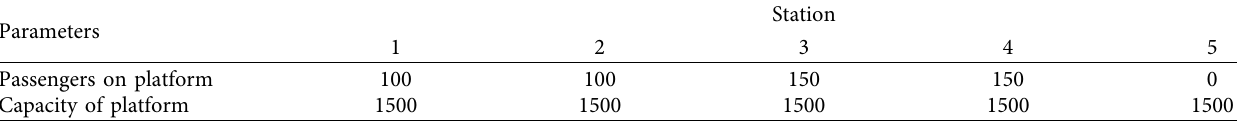
Table 7: The number of passengers on the platform at beginning and the platform capacity (unit: pax).